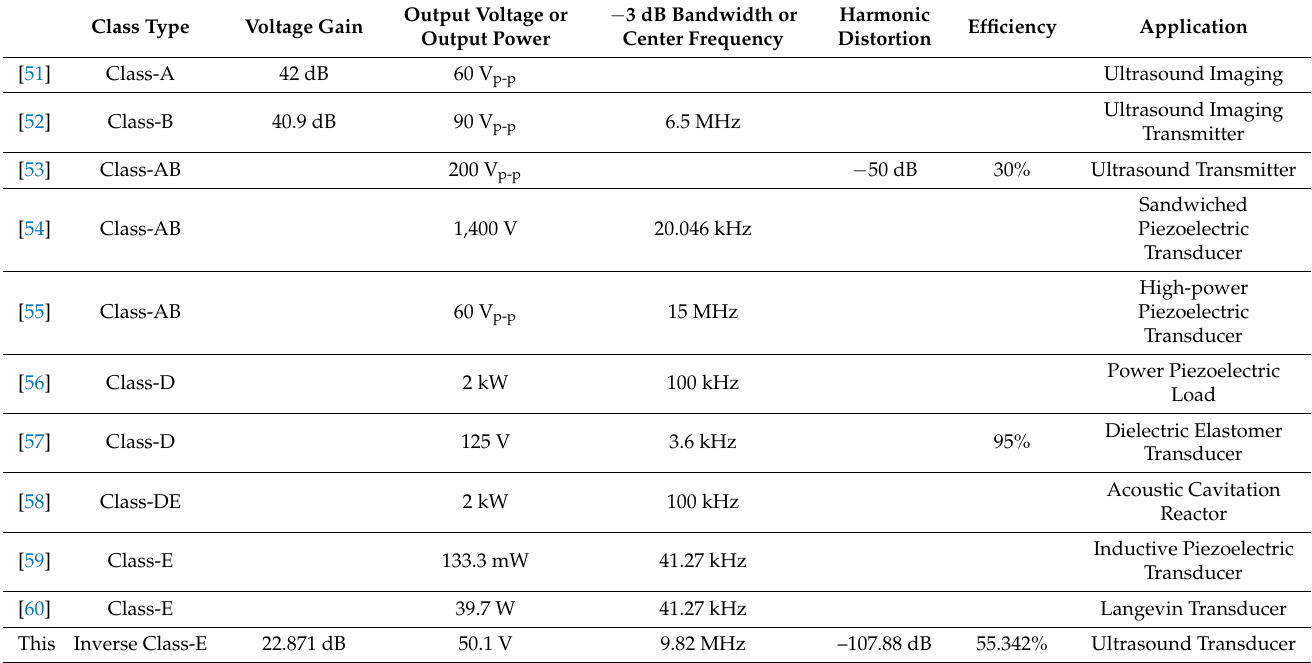
Table 2. Summary of developed amplifiers for ultrasound